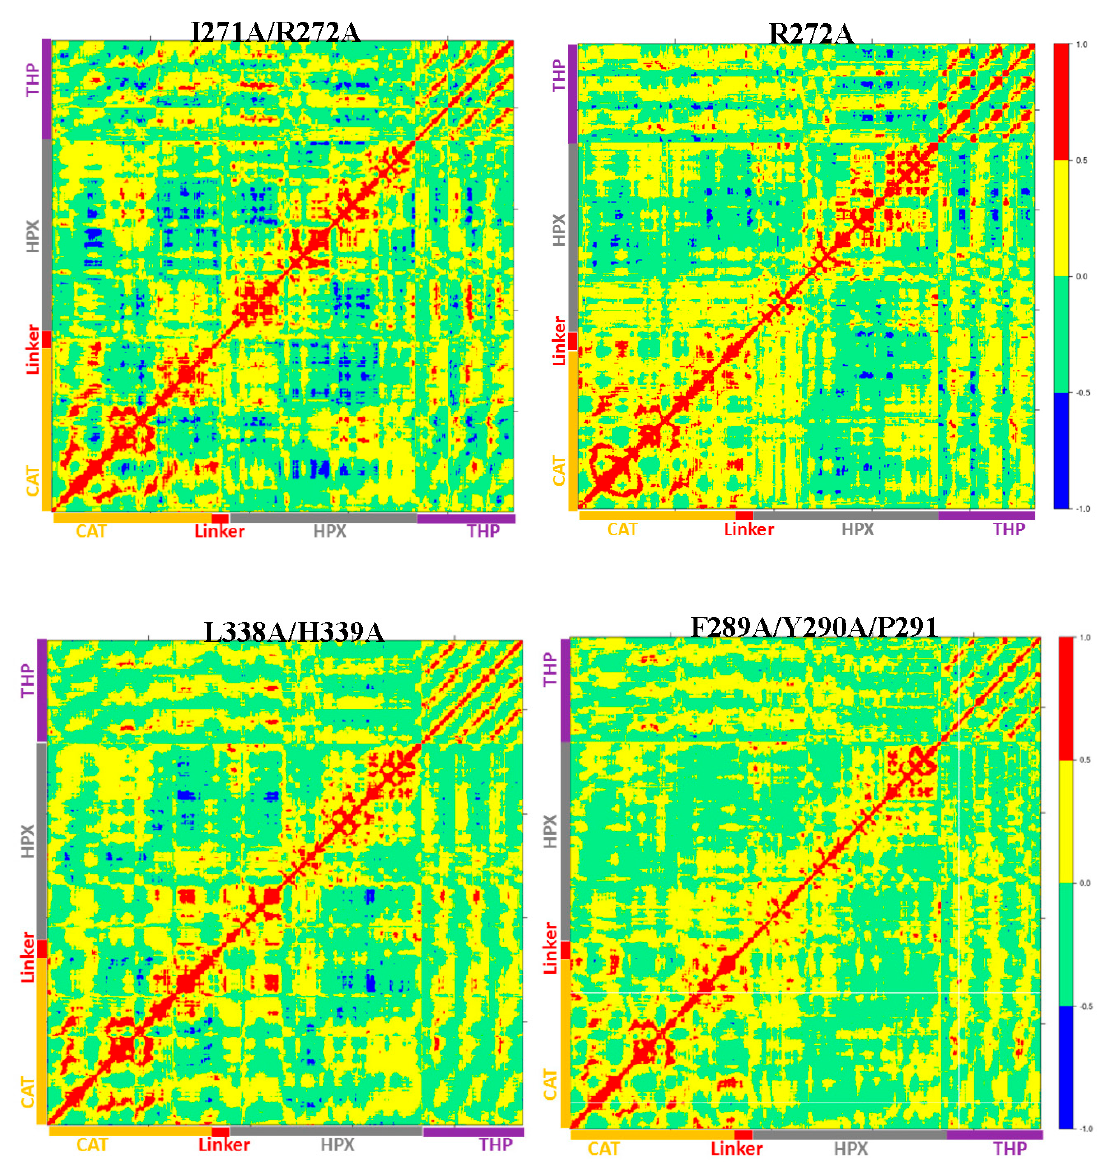
Figure 8. The dynamic cross correlation analysis (DCCA) of MMP-1 • THP and mutants. The scale of correlated motion ranges from +1 to − 1 and represents positive (red) and negative (blue) motions of C α atoms. The analysis was performed using Bio3D package [23] in R for WT MMP-1 • THP, the areas labeled 1–7 indicate positive correlated motions, while the areas labeled 1*–3* indicate negative correlated motions.